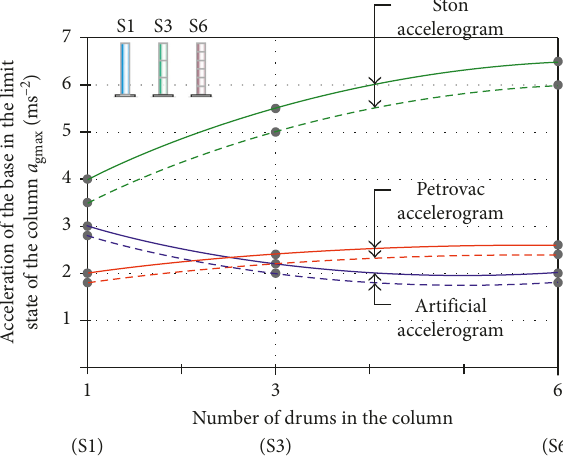
Figure 5: Maximum base acceleration a columns S1, S3, and S6.